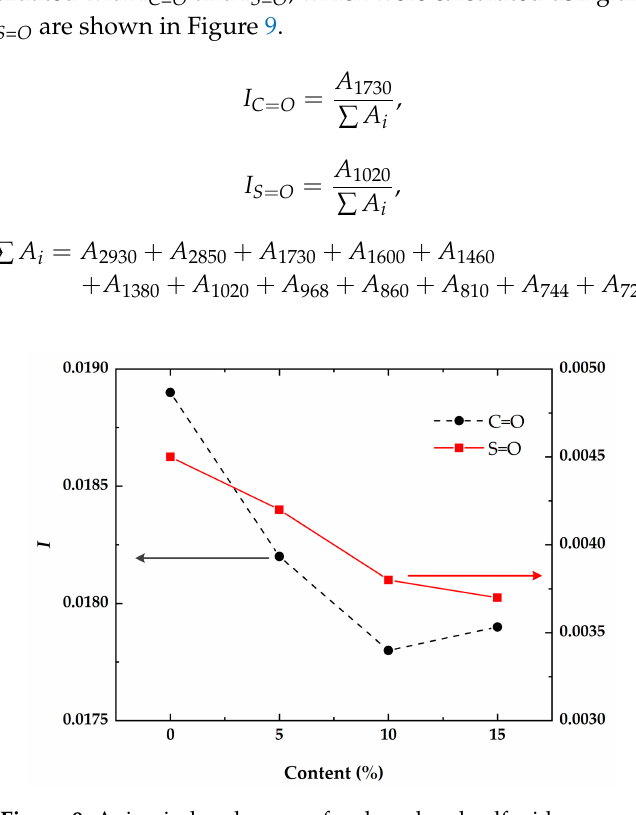
Figure 9. Aging index changes of carbonyl and sulfoxide groups.